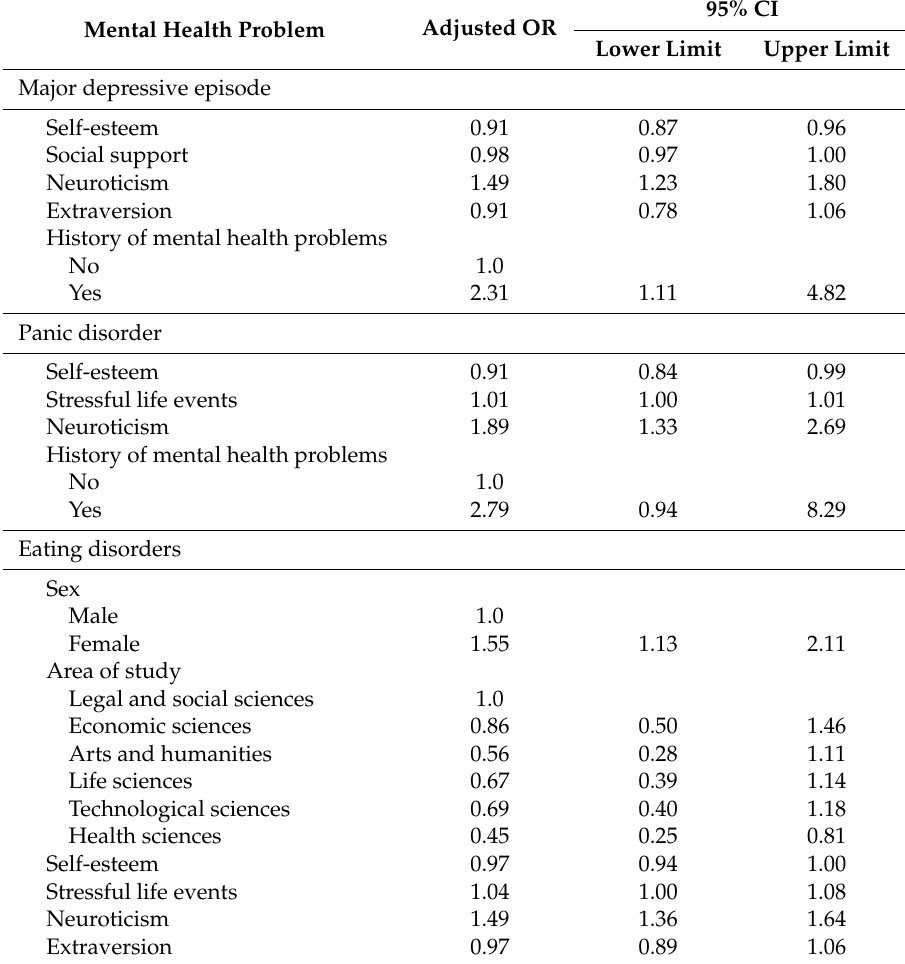
Table 2. Correlates of mental health